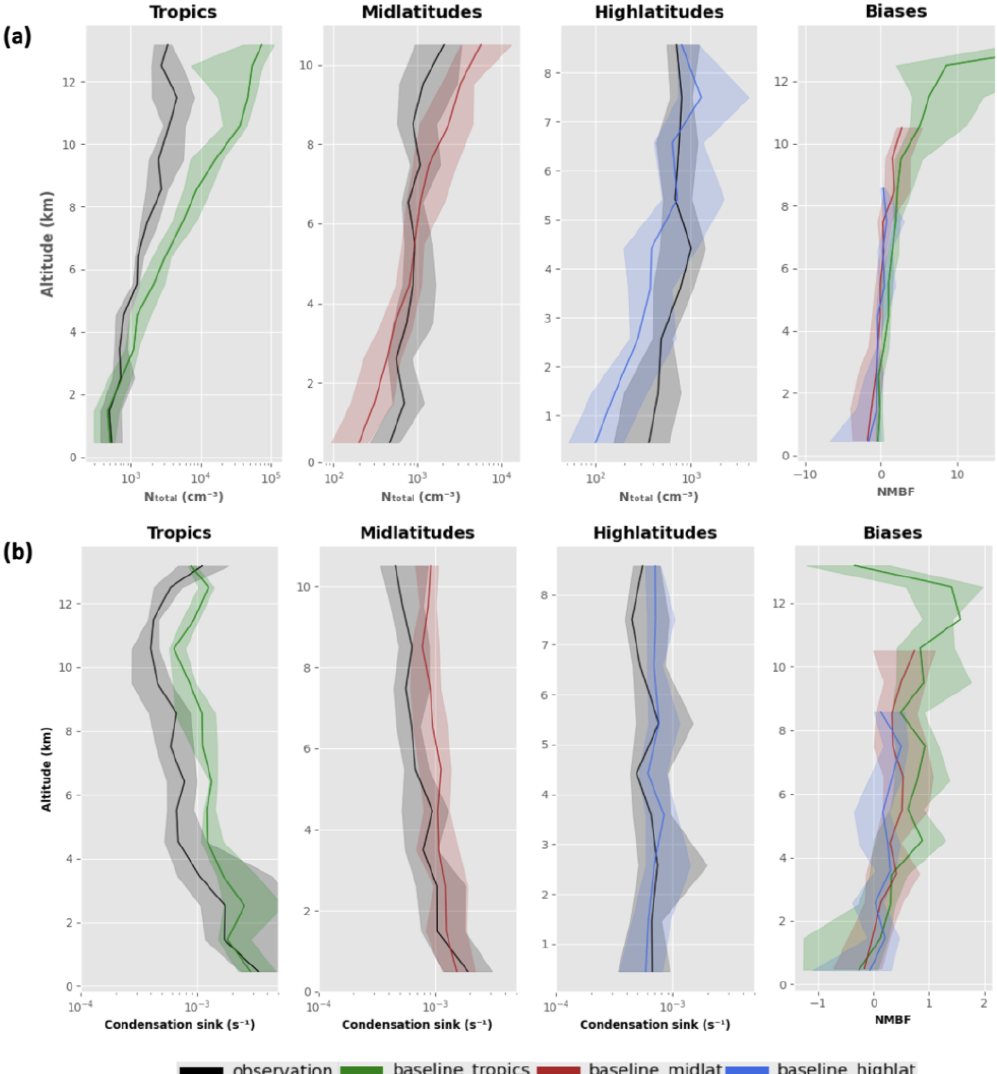
Figure A4. Vertical profiles of the baseline model and observation (a) N Total and (b) condensation sink for only the ATom4 campaign. The first three columns show the vertical profile (at standard temperature and pressure – STP) as observed and in the simulated data from the baseline (bug-fixed) configuration of UKESM in the tropics (25 ◦ N–25 ◦ S), mid latitudes (25–60 ◦ N and 25–60 ◦ S) and high latitudes (60–90 ◦ N and 60–90 ◦ S). The fourth column shows the NMBF of the baseline simulation in the tropics, mid latitudes and high latitudes. The bold line represents the median and the shaded region represents the corresponding interquartile range (25th and 75th percentiles) in a 1km altitude